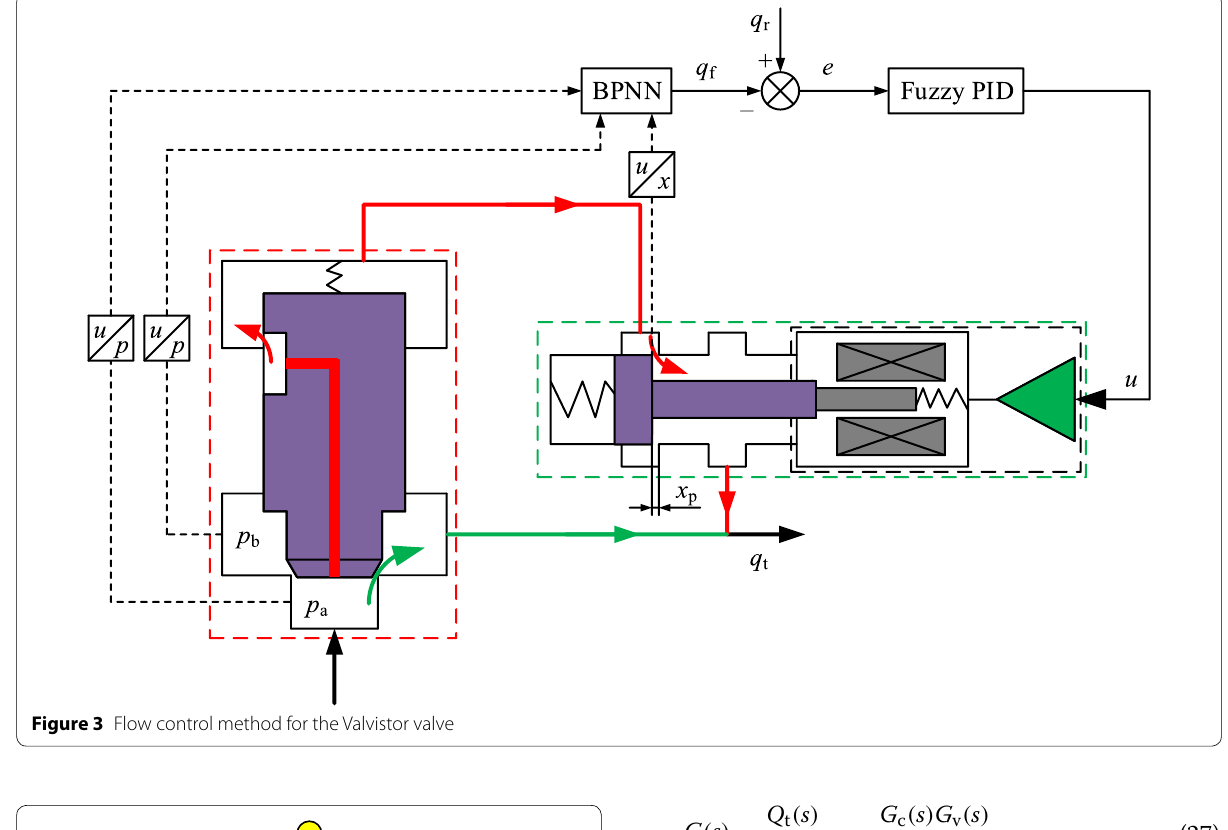
Figure 3 Flow control method for the Valvistor valve